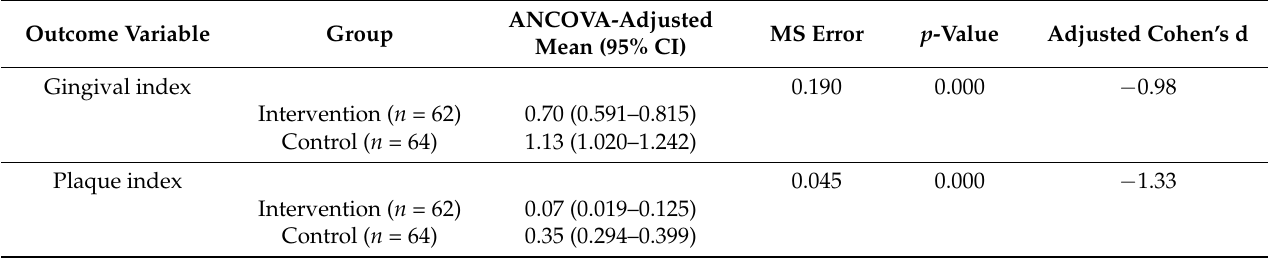
Table 3. Between-group effects of interventions on primary and secondary outcome